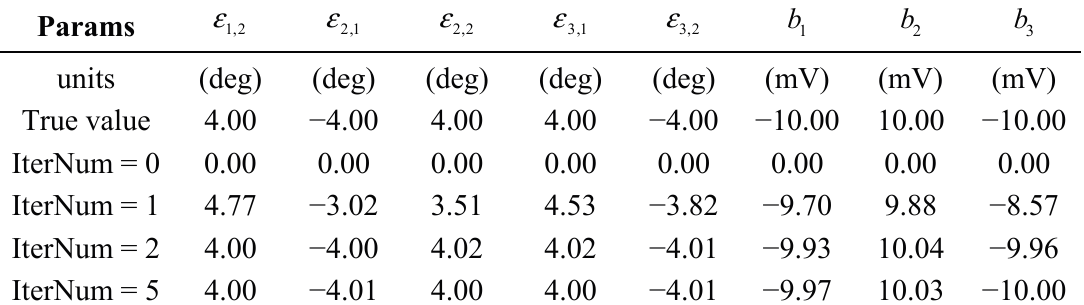
Table 2. Parameters estimation of iterative Least Square based calibration algorithm.